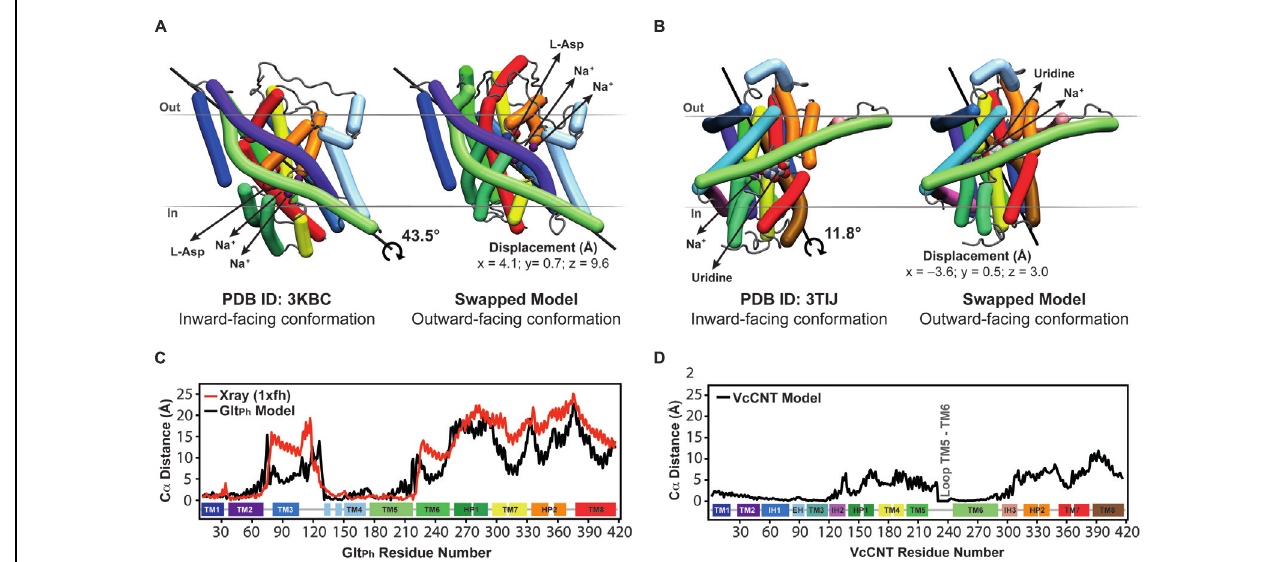
FIGURE 5 | Crystal structures in an inward-facing conformation compared with the final repeat-swapped models of an outward-facing conformation. (A,B) The X-ray crystal structures of a protomer of (A) Glt Ph and (B) VcCNT in an inward-facing conformation ( left ) are compared with the repeat-swapped models of an extracellular-facing conformation ( right ). Structures are viewed along the plane of the membrane, with the extracellular side at the top. The Bendix plugin to VMD was used to represent the helices (Dahl et al., 2012). To quantify the conformational change of the two transporters, the rotation axis, rotation angle, and the displacement of the helices were evaluated. The black line shows the rotation axis, which lies approximately perpendicular to the symmetry axis in each transporter (see Figure 3B ). The displacement values suggest an elevator-like movement of the transport domain containing the substrates ( spheres ), and this displacement is associated with a rotation of 43.5 and 11.8 ◦ , for Glt Ph and VcCNT, respectively. For reference, the conformational change in the transport domain between two X-ray structures of Glt Ph (PDB IDs 3KBC and 1XFH) involves a rotation of 39.6 ◦ and a displacement by x = 3.9, y = 2.8, z = 16.4 Å. (C,D) Displacement per residue determined as the distance between C α atoms in the crystal structure and the model after fitting using the scaffold domains ( black ), for Glt Ph (C) and VcCNT (D) . In the case of Glt Ph , the conformational change between known inward-facing and outward-facing substrate-bound structures is shown ( red